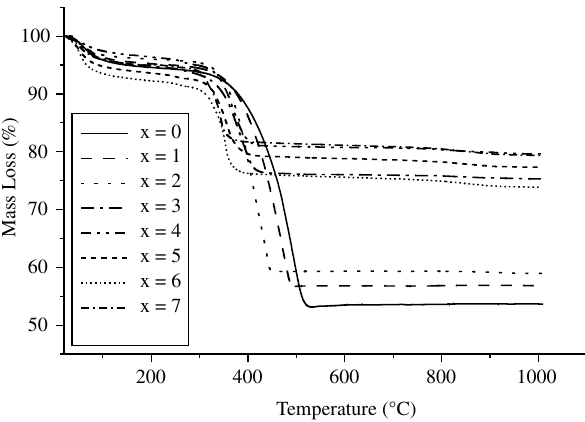
Figure 1. Thermogravimetric curves of samples Zn